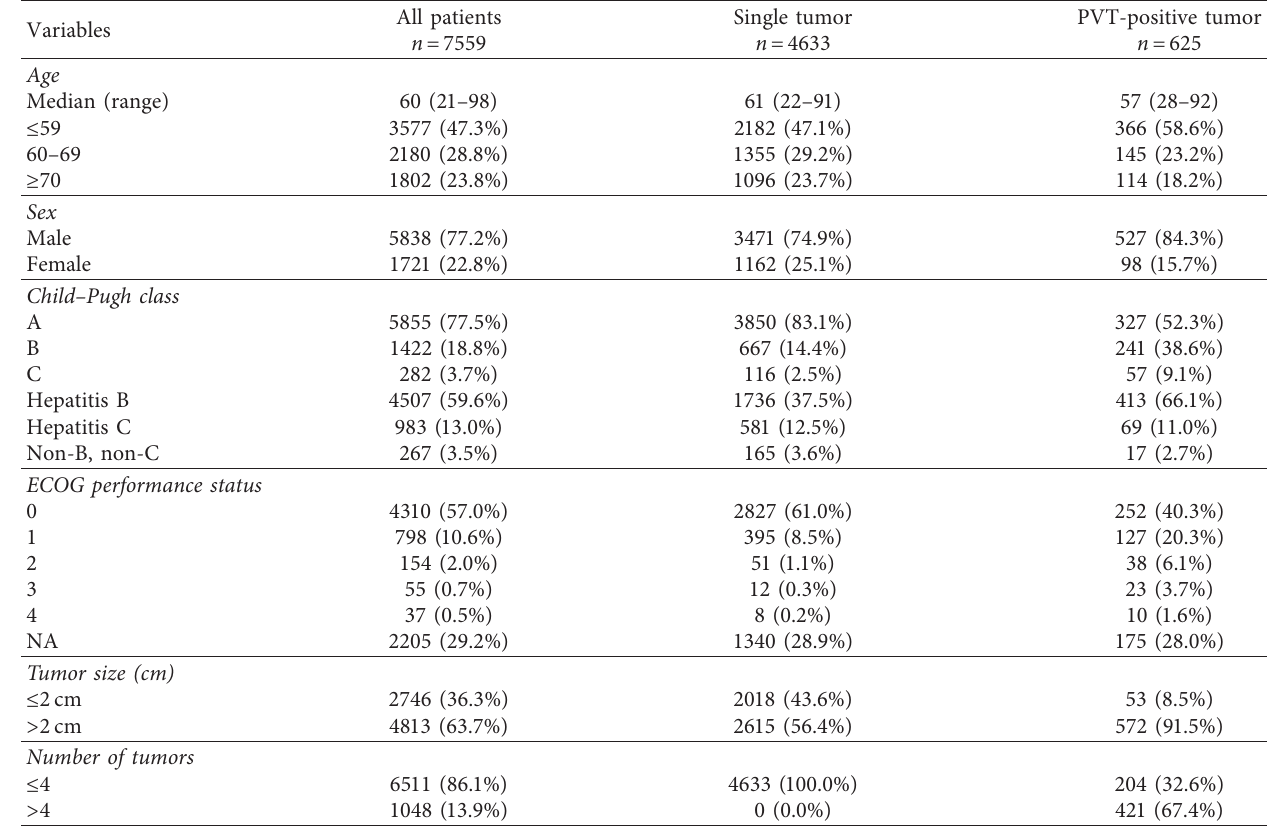
Table 1: Patient characteristics ( n �